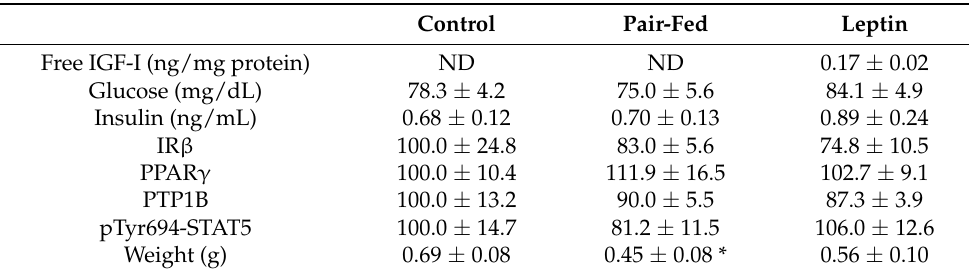
Table 1. Glycemia, insulinemia, and signaling parameters and weight of interscapular brown adipose